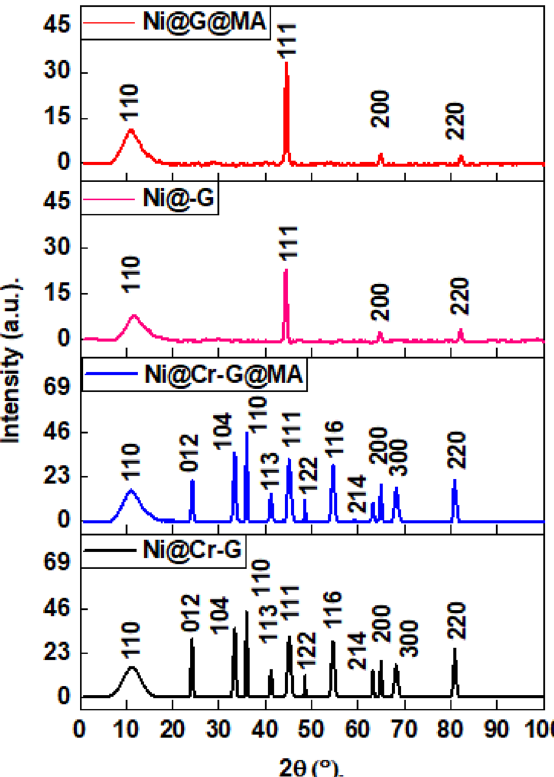
Figure 3. XRD patterns of SHP coated steel by Ni@G, Ni@Cr-G, Ni@G@MA, and